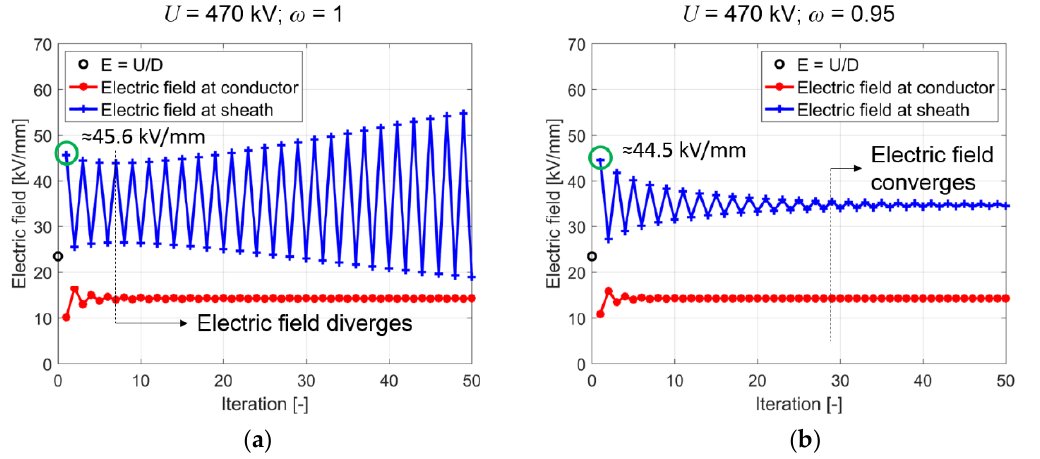
Figure 10. Electric field at the conductor and the sheath in a 20 mm thick MI insulation. ( a ) with an applied voltage of U = 470 kV and ω = 1, the electric field diverges after 5 iterations; ( b ) with a voltage of U = 470 kV and ω = 0.95, the electric field converges [ 71].